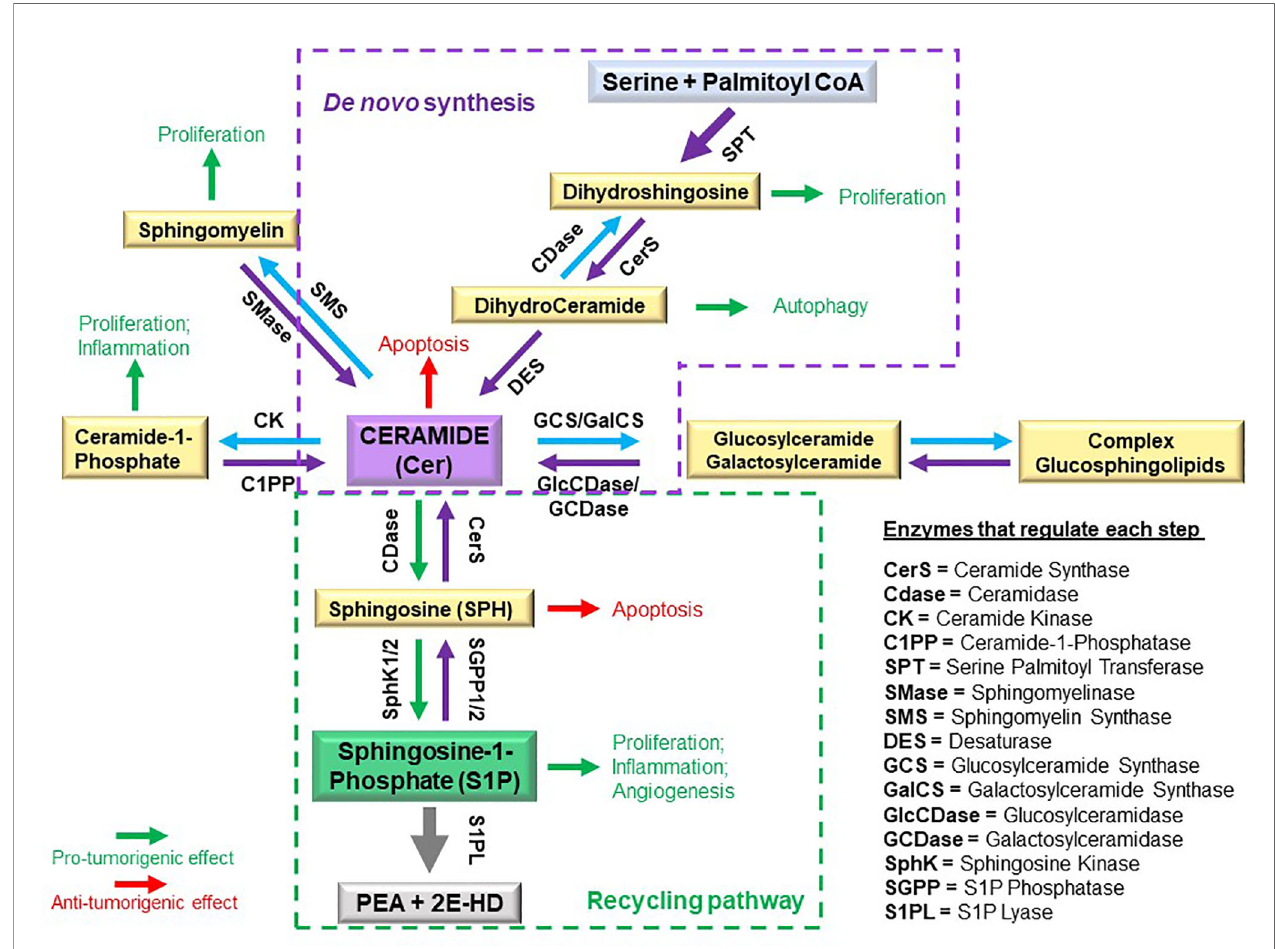
FIGURE 1 | Schematic of sphingolipid metabolism and regulatory interconnections of key enzymes involved in sphingolipid